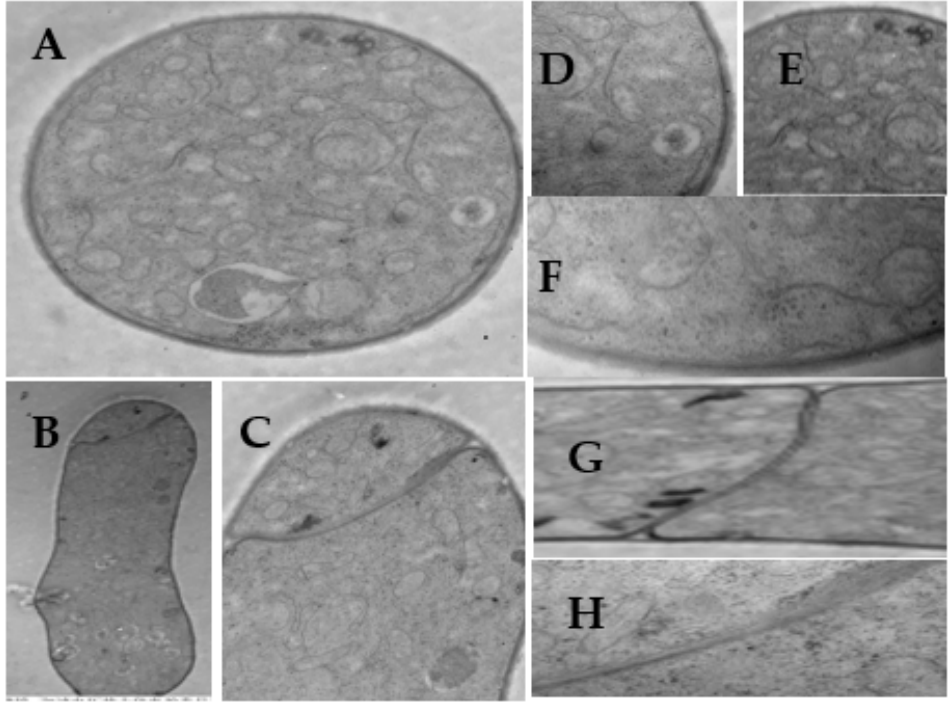
Figure 5. Transmission electron micrographs (TEM) of B. cinerea hyphae in the untreated control. Scale bars: ( A , B , G , H ) 1.0 μm; ( C – E ) 0.5 μm; ( F ) 0.1 μm.